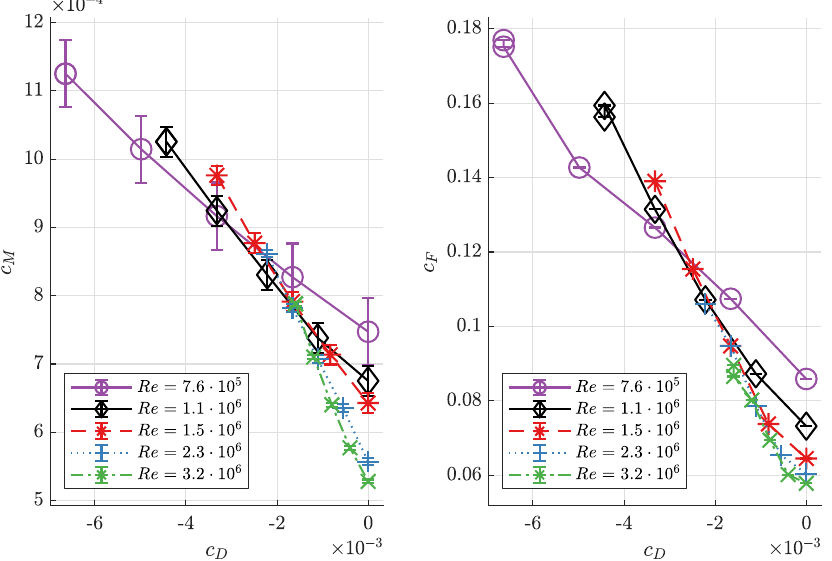
Figure 10. Axial thrust coefficients c F and torque coefficients c M measured in the small test rig (compare [10]) at the small relative cavity width of G = 0.0182: shown are results of a closed cavity